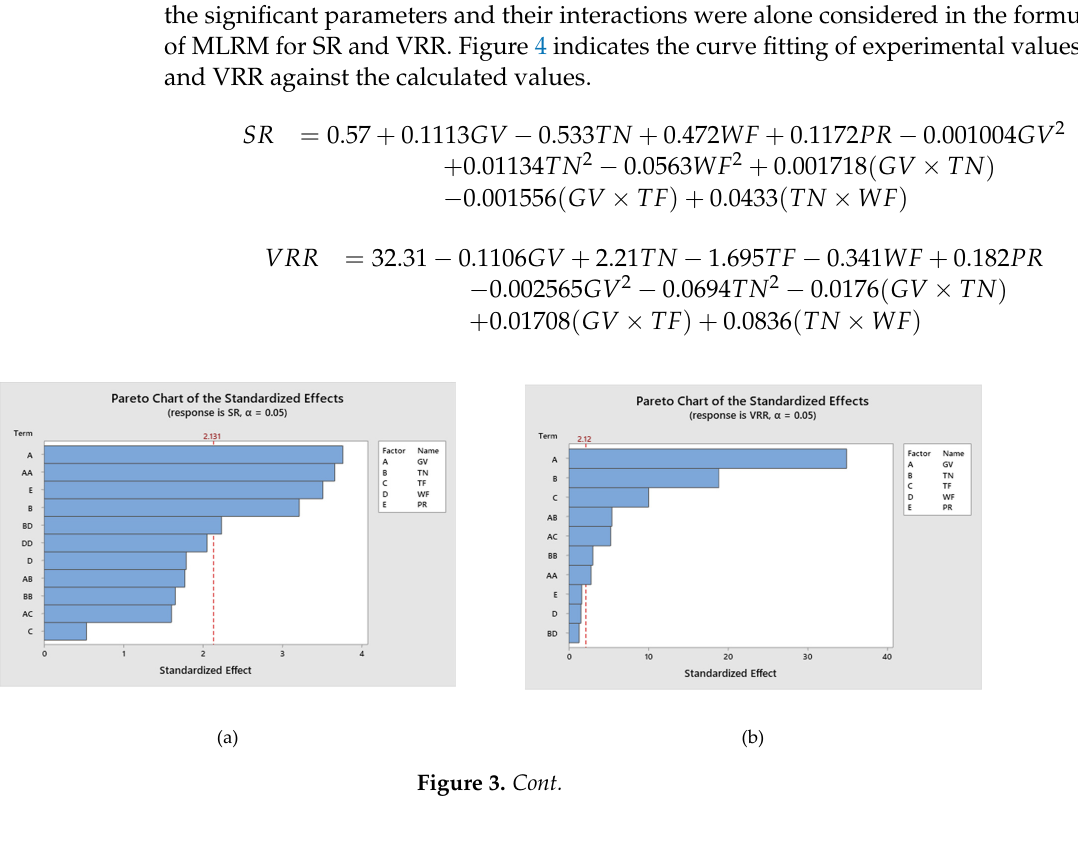
Table 8. ANOVA for